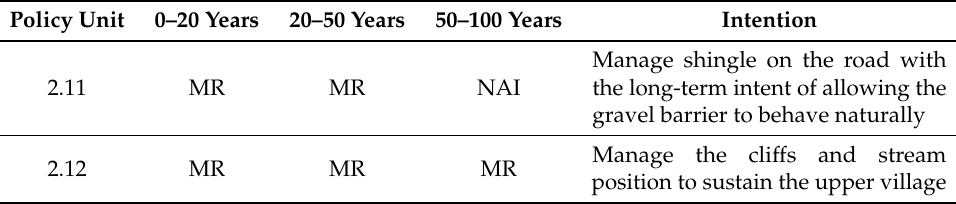
Table 1. SMP2 managed realignment (MR) and no active intervention (NAI) policies for each policy unit in Newgale shown on Figure